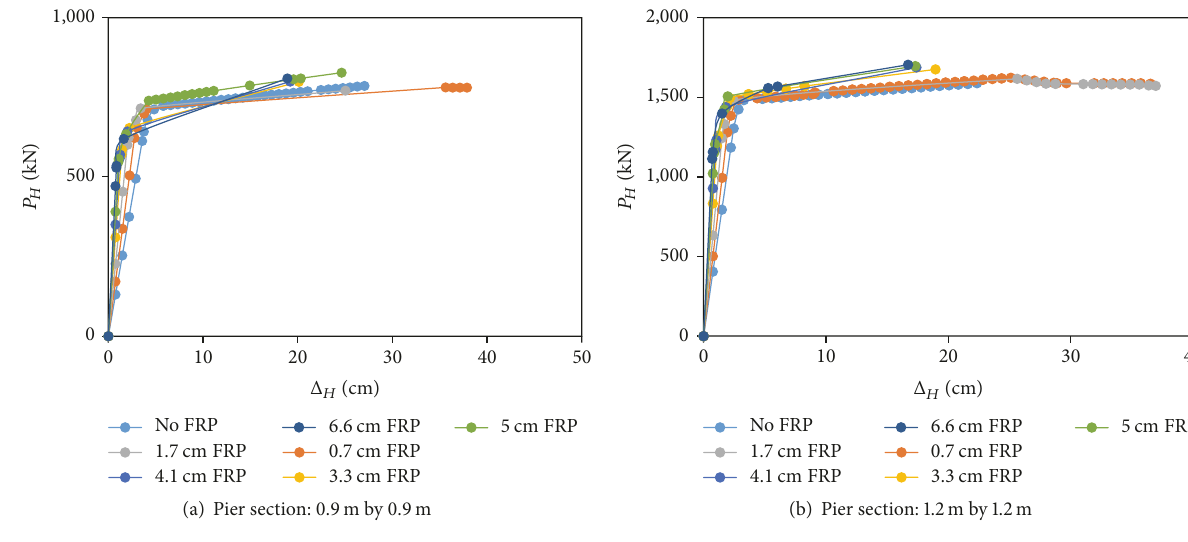
Figure 10: Slender pier system with 𝑊 = 9 m and 𝐻 = 12 m ( 𝑓 󸀠 𝑐 = 41MPa).